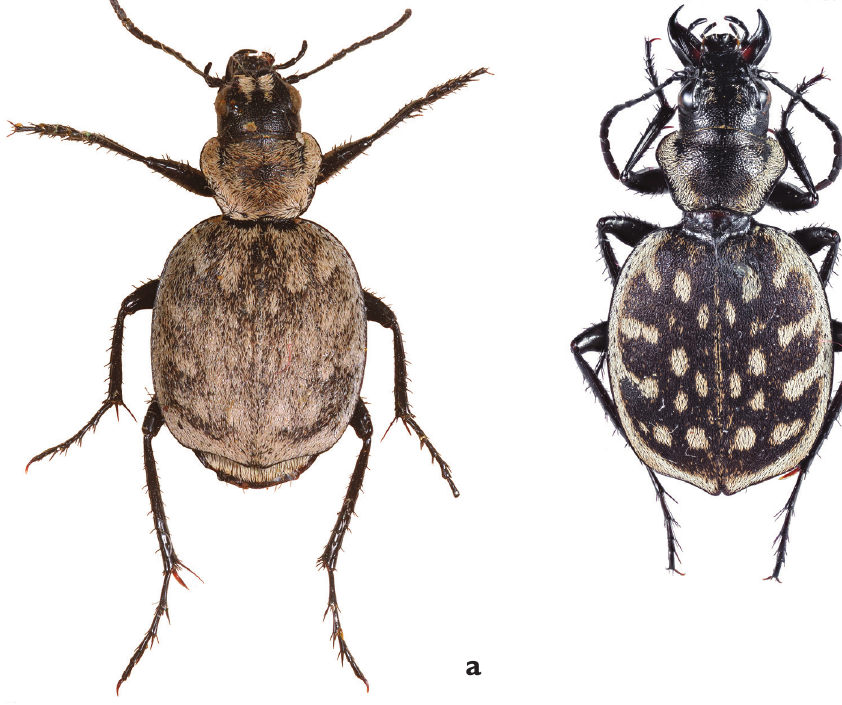
Figure 20. Dorsal habitus of Graphipterus : a G. barthelemyi with greyish scales phase b G. barthelemyi without grayish